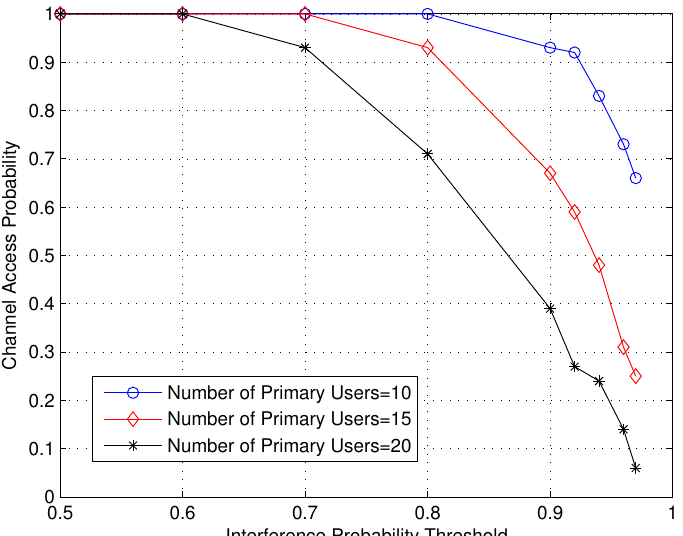
Figure 11. The effect of interference probability threshold on channel access probability for different number of